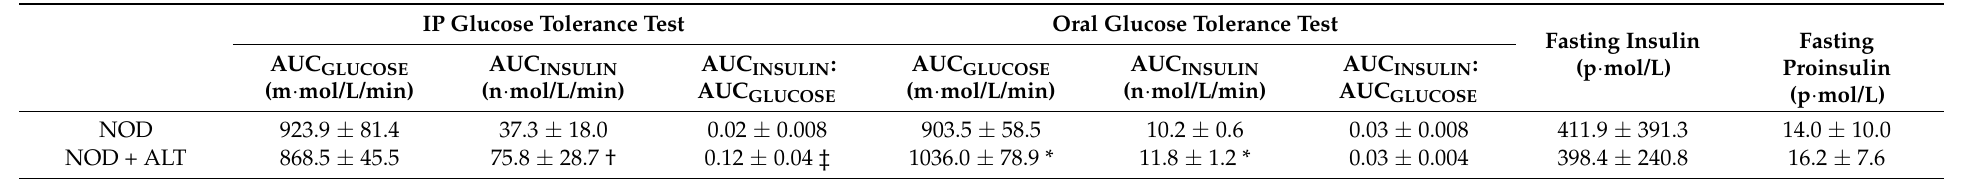
Table 1. Metabolic parameters in pre-diabetic NOD mice following short term AGE lowering therapy. Female NOD ShiLt (NOD) mice from day 50 to 100 of life were untreated or treated with the AGE lowering therapy, alagebrium chloride (ALT, 1 mg/kg/day, s.c). Intraperitoneal (IP) and oral tolerance tests were performed after a 5–6 h fast in response to a 2 g/kg D-glucose bolus at ~day 75 of life ( n = 5–10/group). Area under the glucose (AUC GLUCOSE ) or insulin curve (AUC INSULIN ) measurements were calculated from the IPGTT and OGTT curves (0 min–120 min; see curves presented in Figure S1). First phase AUC GLUCOSE :AUC INSULIN has been taken as 0–15 min of the glucose tolerance test. Data are reported as mean ± SD. † p = 0.002 vs. NOD (Unpaired Student’s t -test); ‡ p < 0.0001 vs. NOD (Mann-U Whitney); * p = 0.02 vs. NOD (Unpaired Student’s t -test).